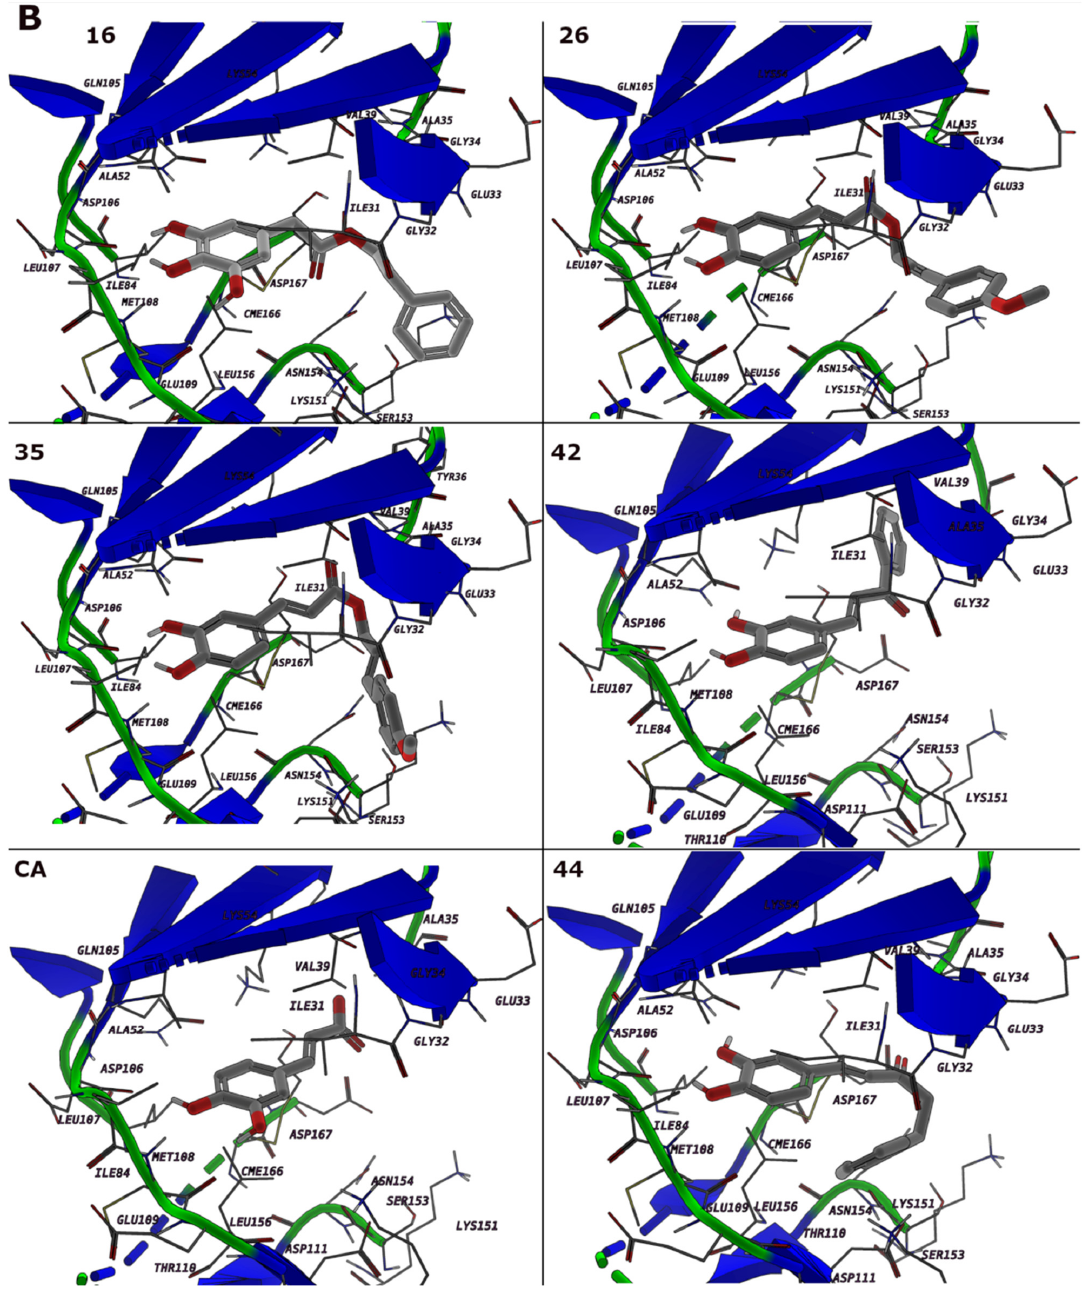
Figure 8. The interaction of selected analogs of phenolic acids with ERK depicted by molecular docking. ( A ). The binding modes of the phenolic acid analogs. I. Alignment of selected analogs in the active site of ERK2. II . Caffeic acid interaction model. III . Analog 12 interaction model. The protein is shown as cartoon, ligand as sticks, and the interacting amino acids as lines. ( B ). The interaction models of selected phenolic acid analogs; 16 , 26 , 35 , 42 , Caffeic acid, and 44 . The protein is shown as cartoon, ligand as sticks, and the interacting amino acids as lines. Caffeic acid is given as the reference frame for comparison. Caffeic acid interacts through HB with Asp106 and Met108. It shows electrostatic contacts with Lys54, Gln105, Asp106 and Lys114. It exerts several hydrophobic contacts with Ile31, Gly34, Ala35, Val39, Ala52, Ile84, Leu107, Met108 and Leu156. Compound 12 exhibits these types of interactions with the surrounding amino acids; hydrogen bonds with Gln105, Asp106, and Met108, electrostatic type with Glu33, Lys54, Gln105, Asp106, Asp111, Lys114, Lys151, Asn154, Ser153, and Asp167, and hydrophobic contacts with Ile31, Gly34, Ala35, Val39, Ala52, Ile84,